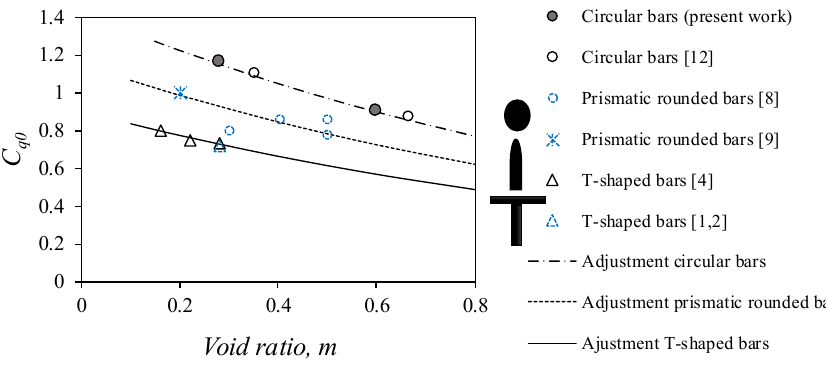
Figure 6. Static discharge coefficient measurements and proposed adjustments.